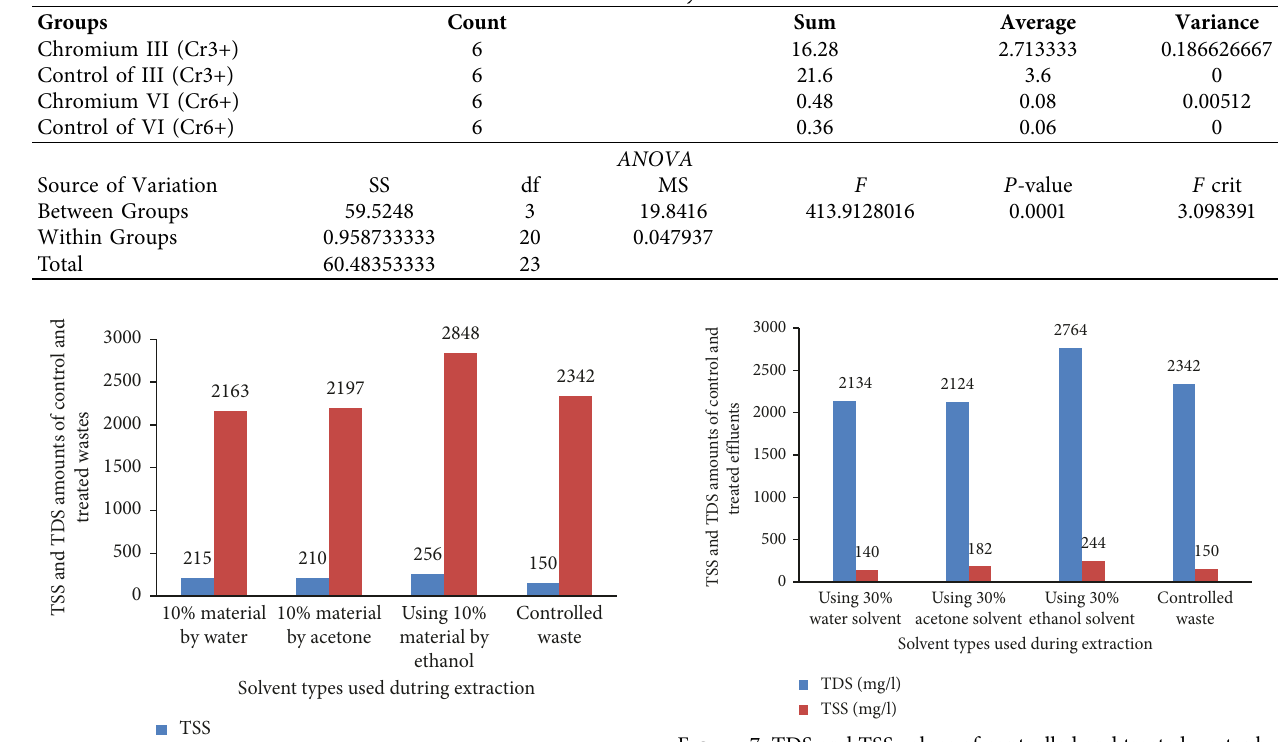
Figure 5: The effect of extraction solvents on chromium (III) and chromium (VI) removal of the tannery waste Table 2: ANOVA results of the effect of the solvent on the WH leaf extract efficacy. Summary